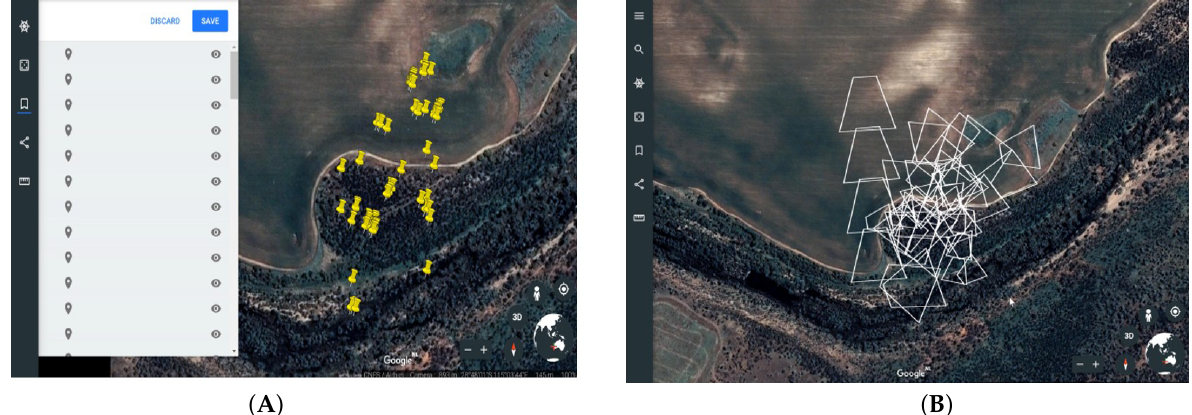
Figure 7. ( A ) The geo-tagging of detected animals from drone data that points out their detection location and ( B ) visualisa- tion of animal movements that display the area of their